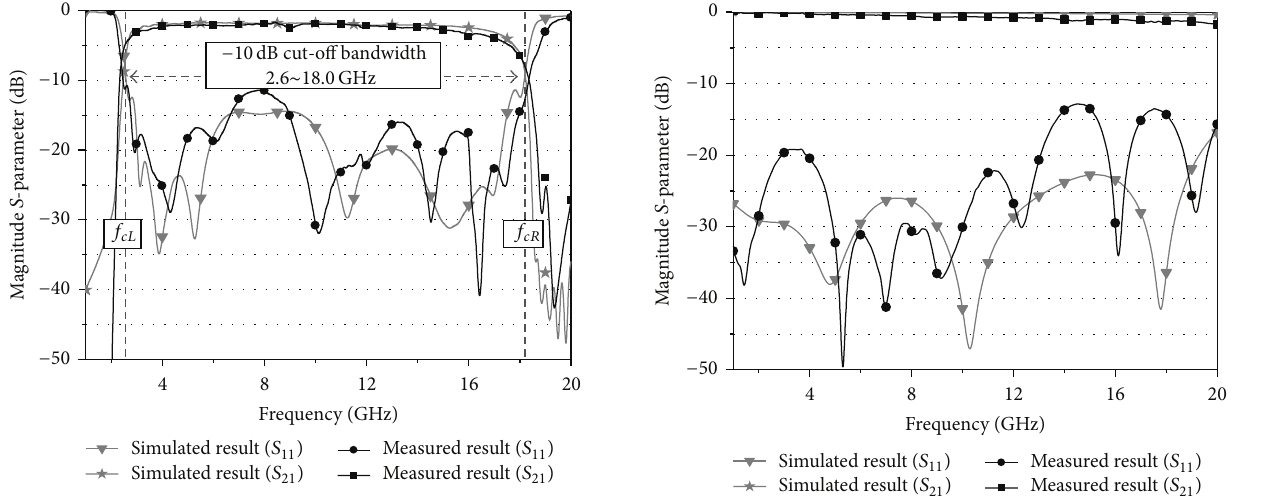
Figure 5: Simulated and measured results of the fabricated transi- tion in a back-to-back configuration with connectors.